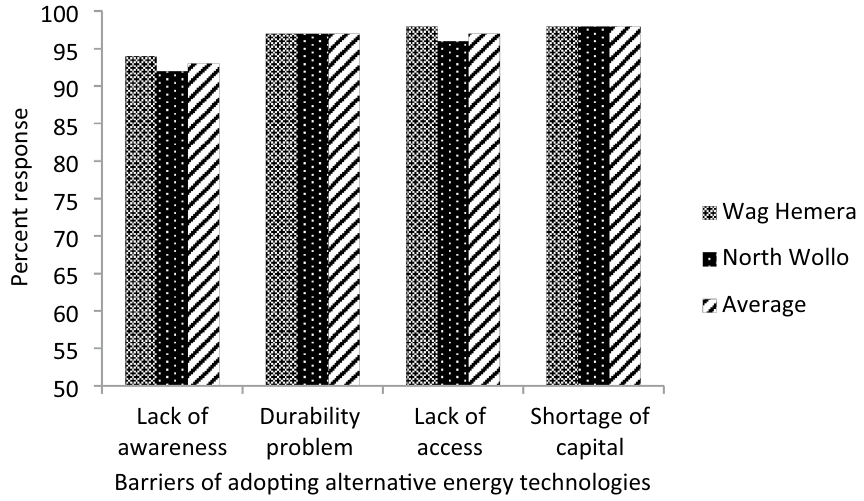
Figure 2. Perceived barriers to adoption of modern energy technologies in Wag Hemera and North Wollo zones, northern